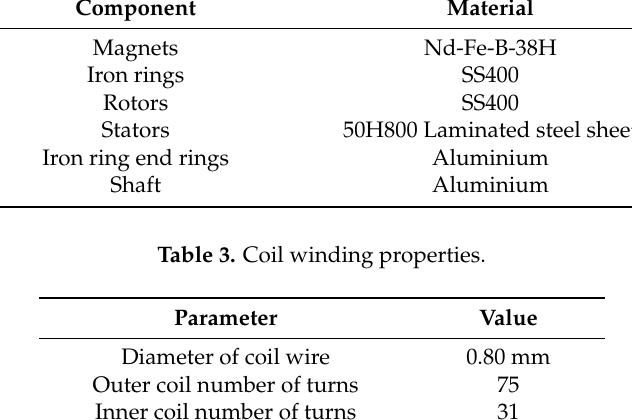
Table 2. Material properties of components.